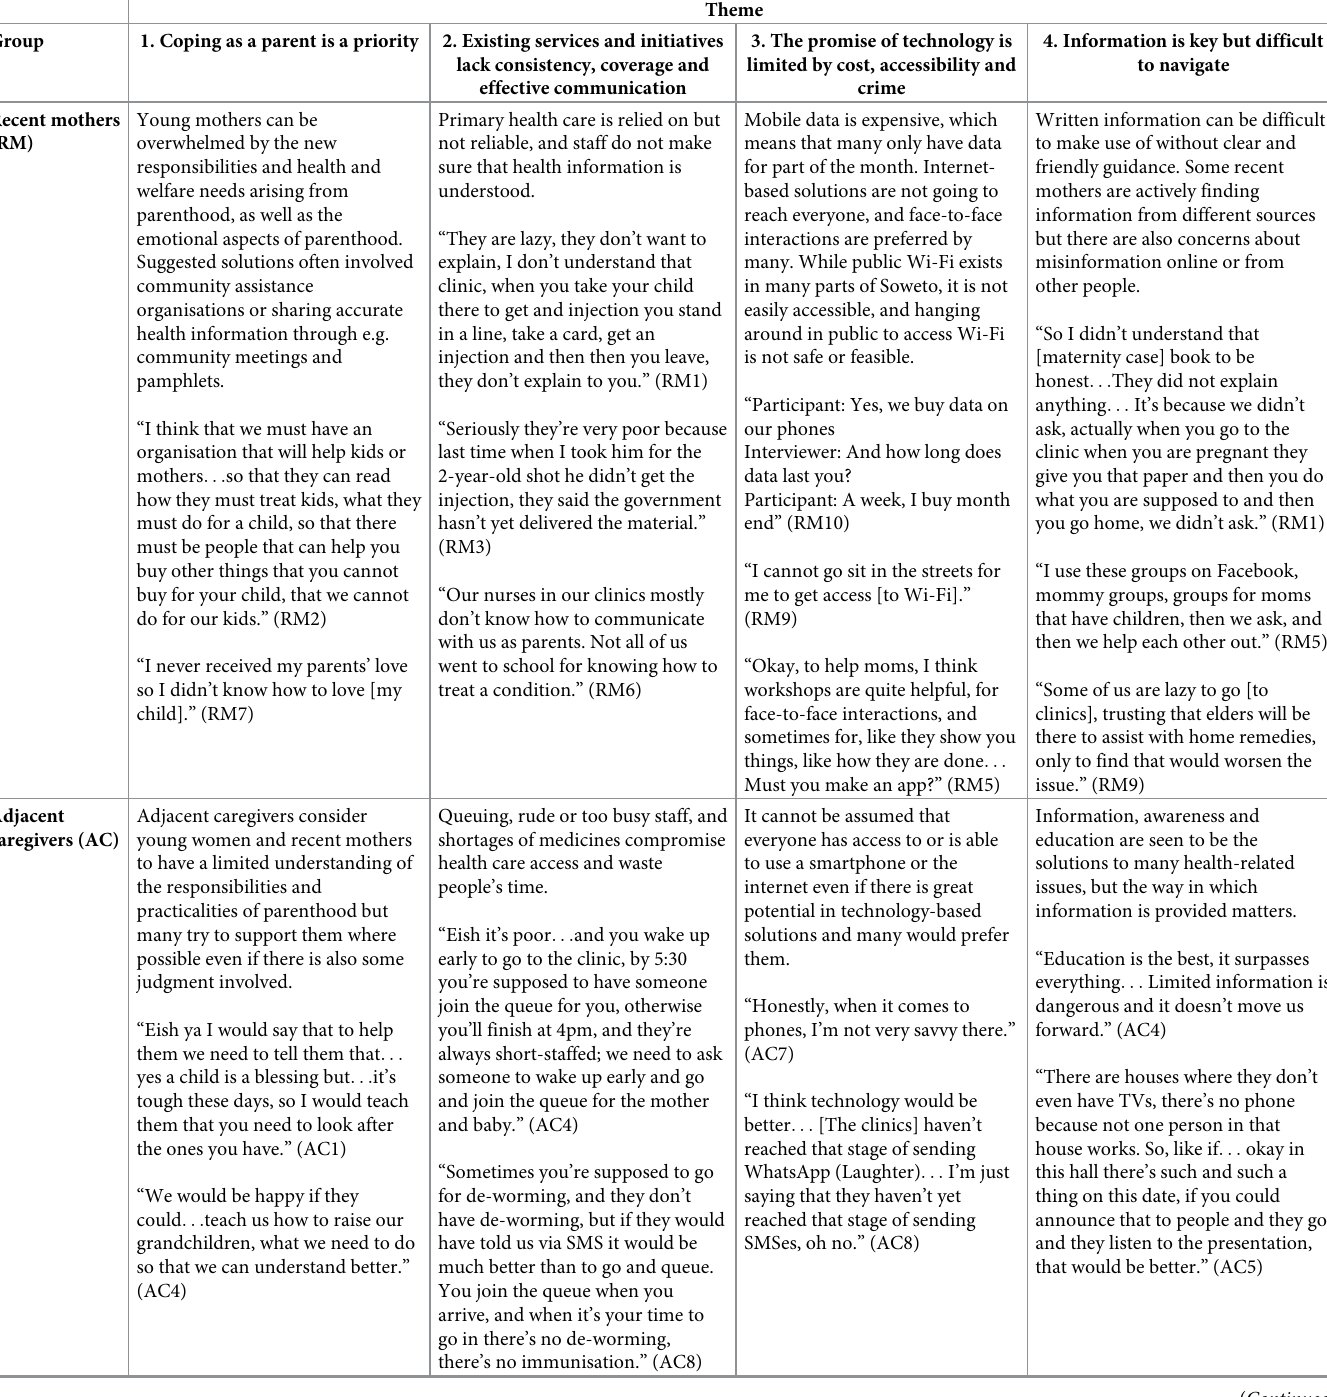
Theme lack consistency, coverage and effective communication